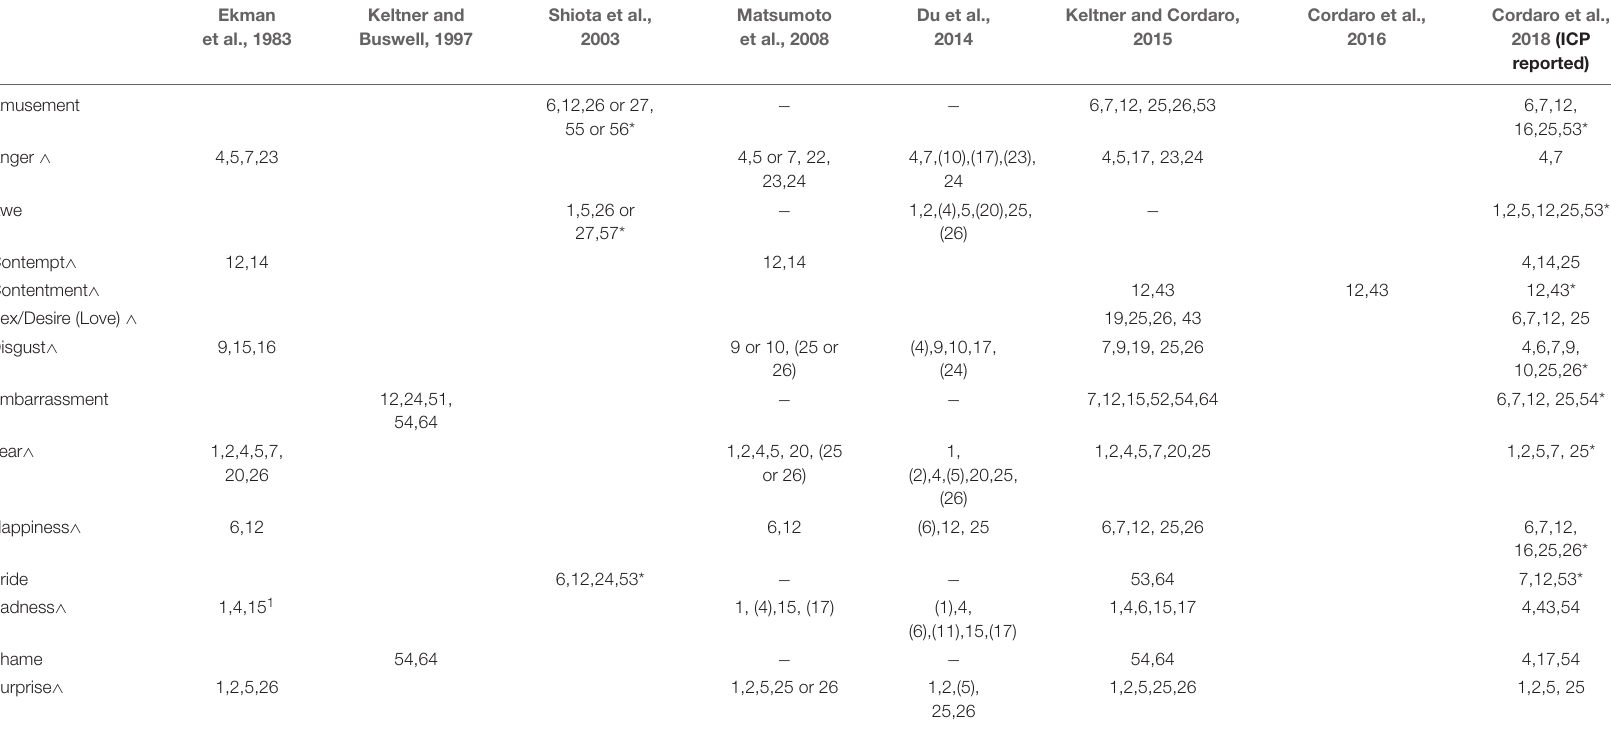
TABLE 1 | AU Prototypes across